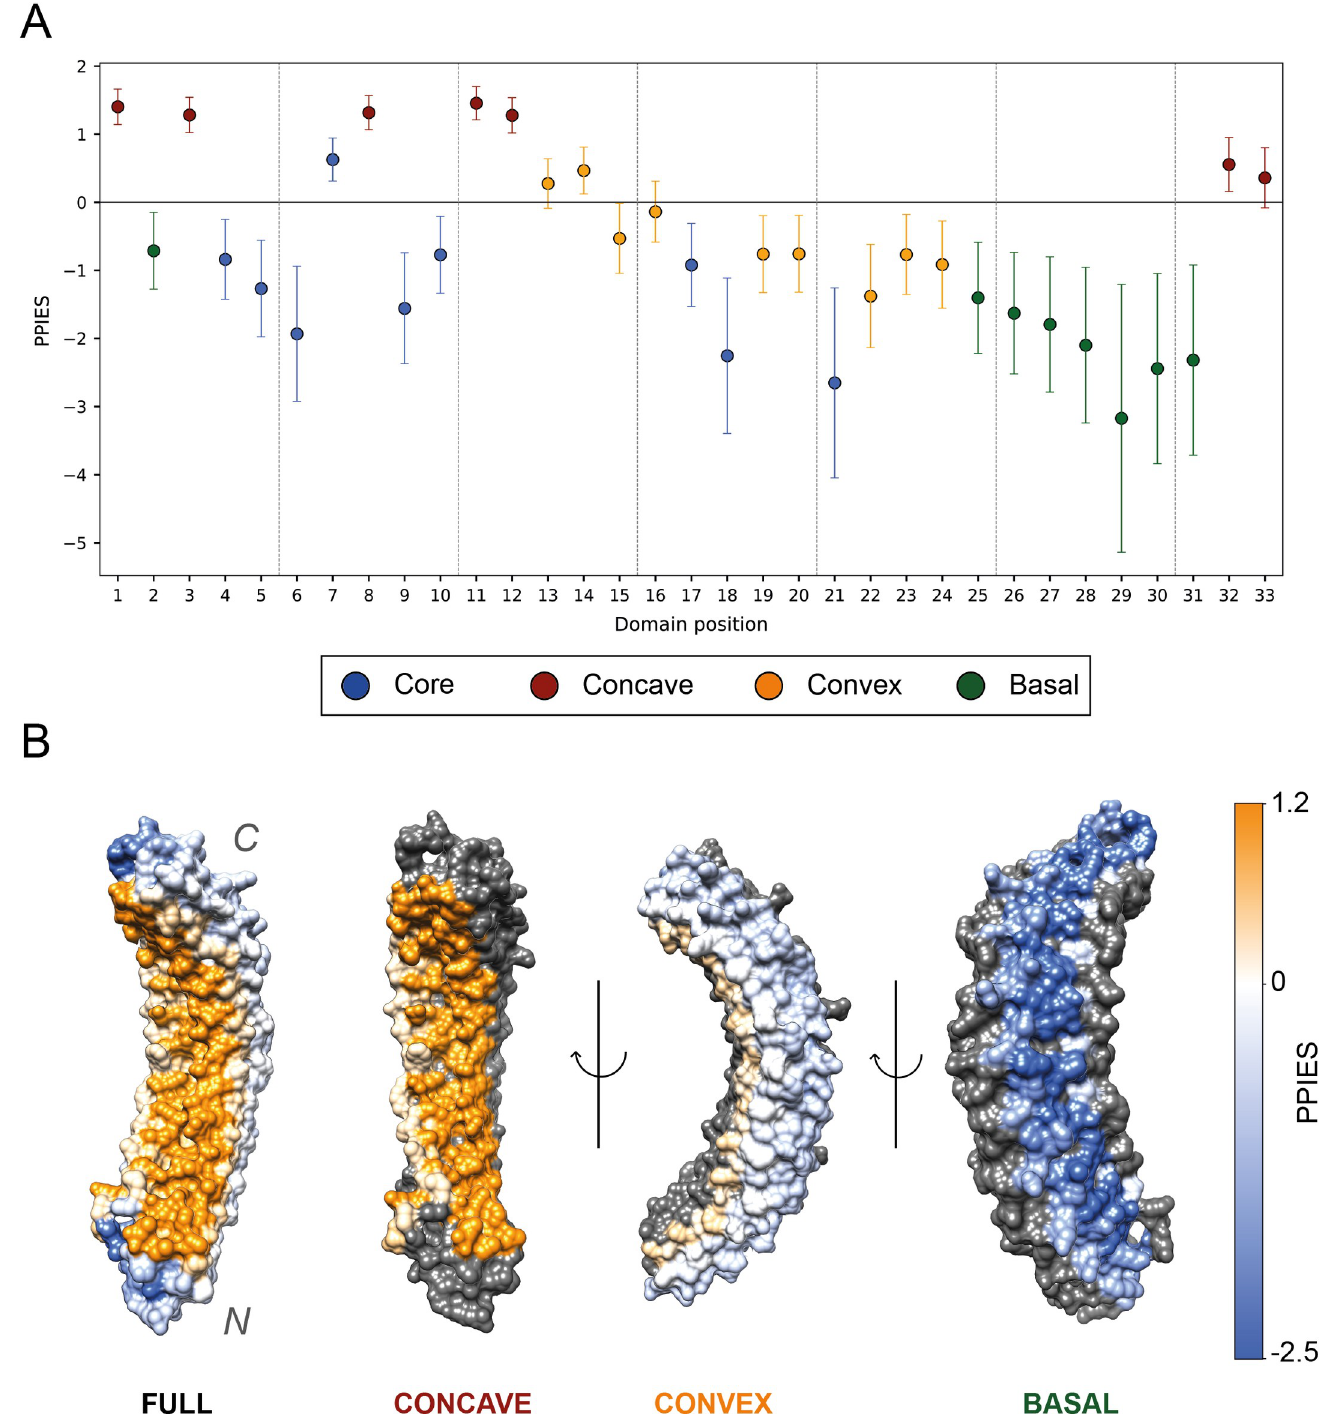
Fig 11. (A) Protein-substrate interactions enrichment plot. Error bars indicate 95% CI of the protein-protein interactions enrichment score (PPIES), i.e., ln (OR). Data points are coloured according to their surface classification (Table 1); (B) D34 region of ANK1 ARD, PDB accession: 1N11 [53]. This structure shows 12 out of the 23 ARs found on this ARD. Residues are coloured according to the PPIES of the alignment column they align to in the MSA. The colour scale goes from blue (depleted in PPIs) to orange (enriched in PPIs) going through white (neutral). From left to right, the whole domain, then the concave, convex and basal surface are coloured. On each of the last three representations, only one surface is coloured. Residues not belonging in that surface are coloured in grey. Overall, the concave surface is coloured in a strong orange colour, indicating its importance in protein binding, whereas the basal one presents a dark blue colour, indicative of its overall depletion in PPIs. Figure obtained with UCSF Chimera